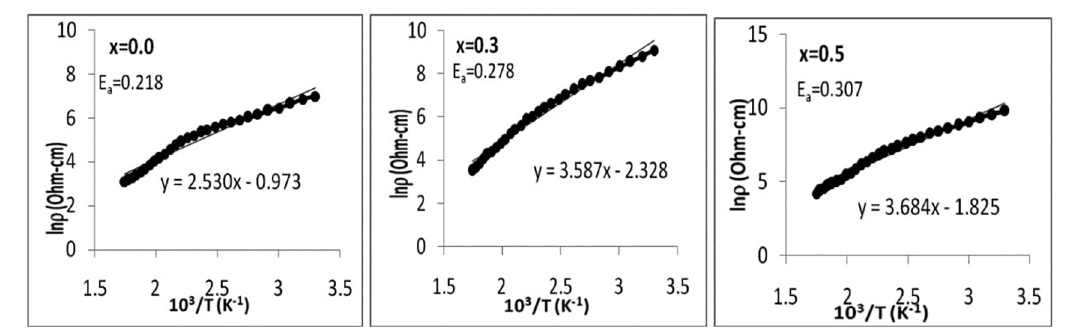
Figure 4. Arrhenius plot between log( and 10 3 /T for samples x=0.0, 0.3 and